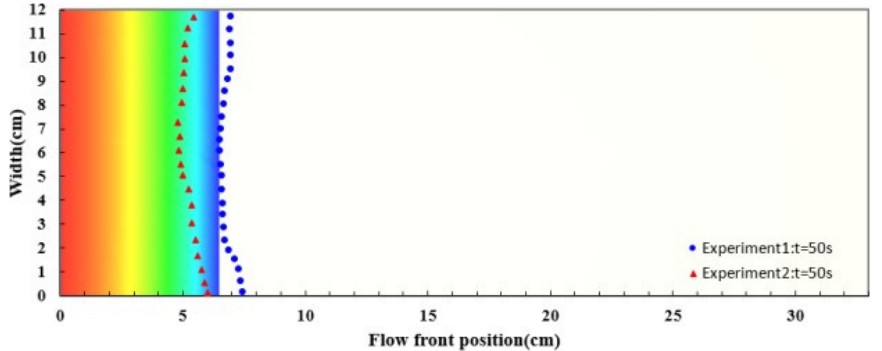
Figure 20. Snapshot of flow front positions at the 50th second in the case study of nine-layer fiber preform.